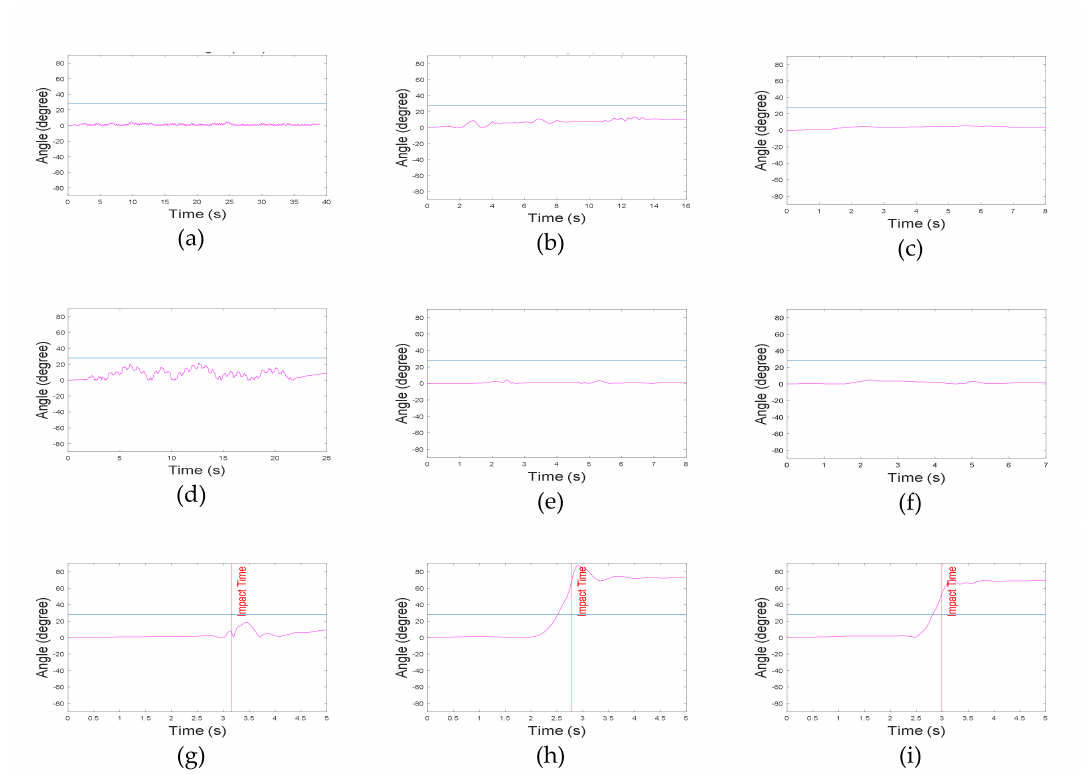
Figure 6. Roll angle graphs. Less-dynamic motions: ( a ) walking, ( b ) climbing up and down the stairs, and ( c ) slowly sitting the on stool and getting up. Highly dynamic motions: ( d ) jogging, ( e ) quickly sitting on the chair and getting up, and ( f ) quickly sitting on low-height mattress and getting up. Fall motions: ( g ) backward fall, ( h ) lateral fall, and ( i ) twist